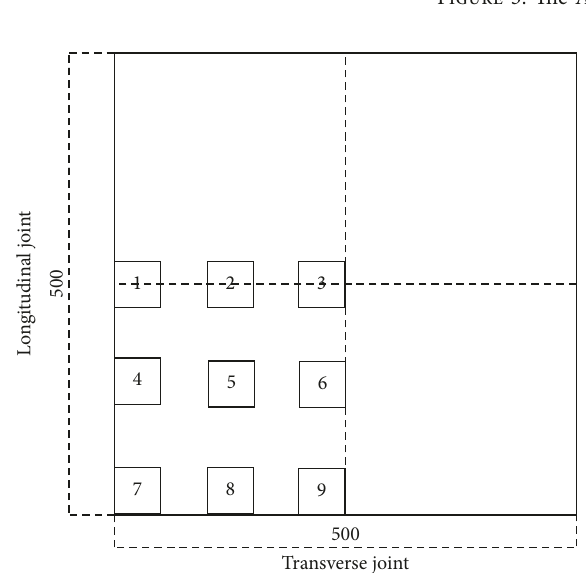
Figure 4: The stress gauges layout schematic